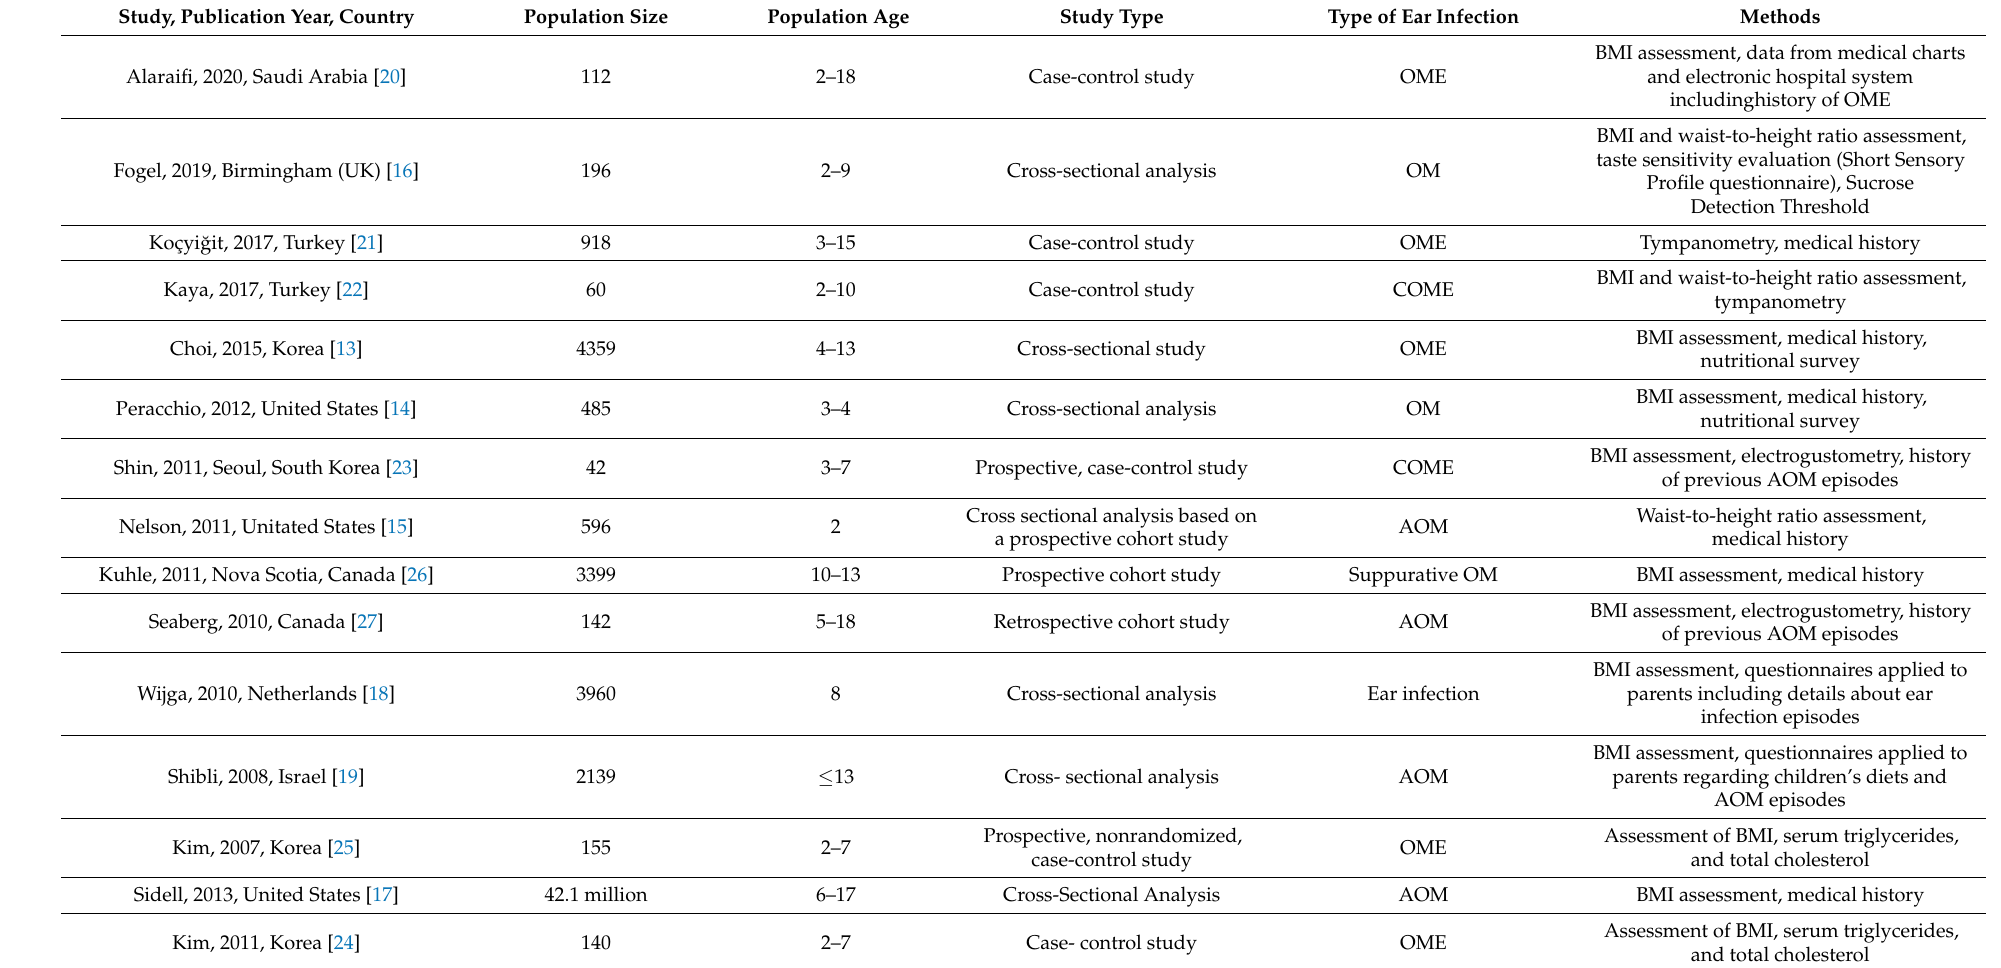
Table 1. Summary of basic characteristics of the included